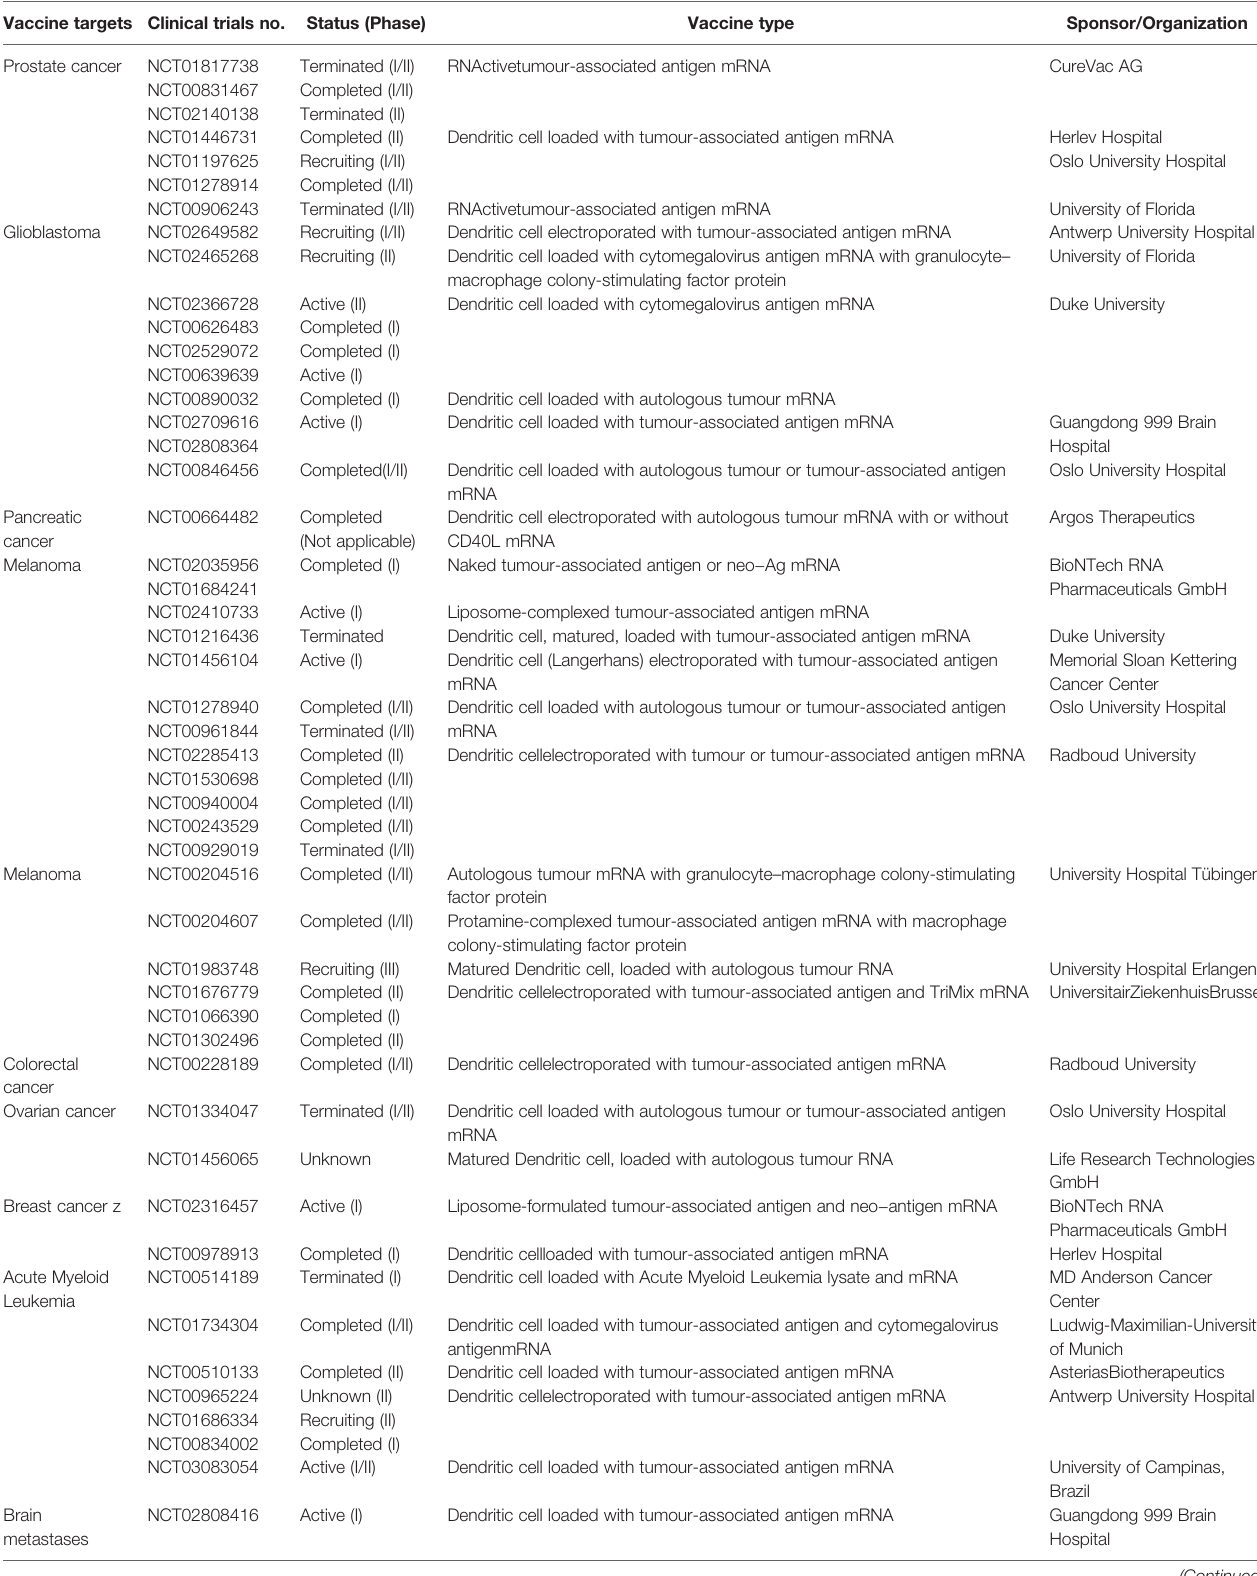
TABLE 2 | Different mRNA based cancer vaccines which are registered for different phases of the clinical trial. Vaccine targets Clinical trials no. Status